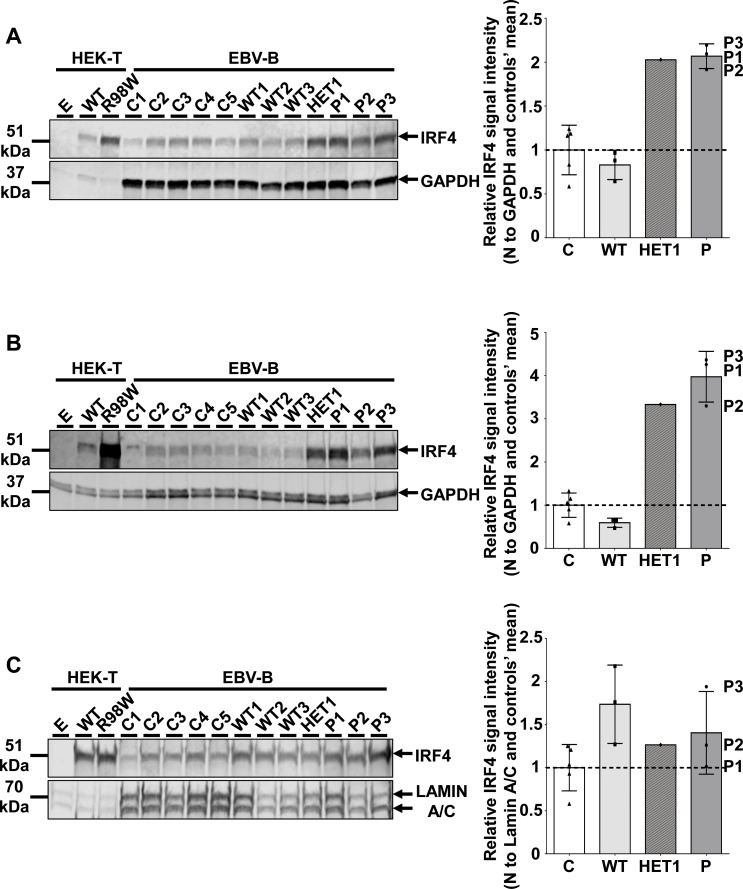
IRF4 protein levels in EBV-B cells. (A–C) (Left) Total cell (A), cytoplasmic (B) and nuclear (C) extracts from five healthy unrelated controls (C1 to C5), three homozygous WT relatives (WT1, WT2, WT3), three patients (P1 to P3) and one asymptomatic heterozygous relative from the kindred (HET1). Protein extracts from HEK293T cells transfected with the pcDNA3.1 empty vector (E), or plasmids encoding IRF4 WT or IRF4 R98W were used as controls for the specific band corresponding to IRF4. (Right) Representation of IRF4 signal intensity for each individual relative to the mean signal for healthy unrelated controls (n = 5) obtained on western blotting (Figure 4A–C left) and represented by black dotted lines, with normalization against the GAPDH signal (total, cytoplasmic extracts) or the lamin A/C signal (nuclear extracts). The results shown are representative of two independent experiments.